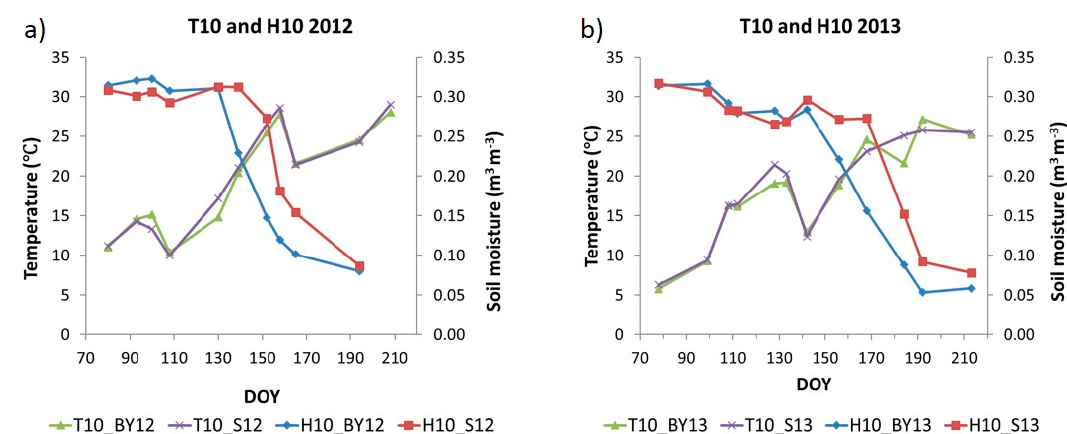
Figure 6. Soil moisture (H10) and Soil temperature (T10) dynamics at 10 cm depth. Average values for the two barley plots (BY) and measured values for the bare soil plot (S) in 2012 ( a ) and in 2013 ( b ) in Madrid, Spain.